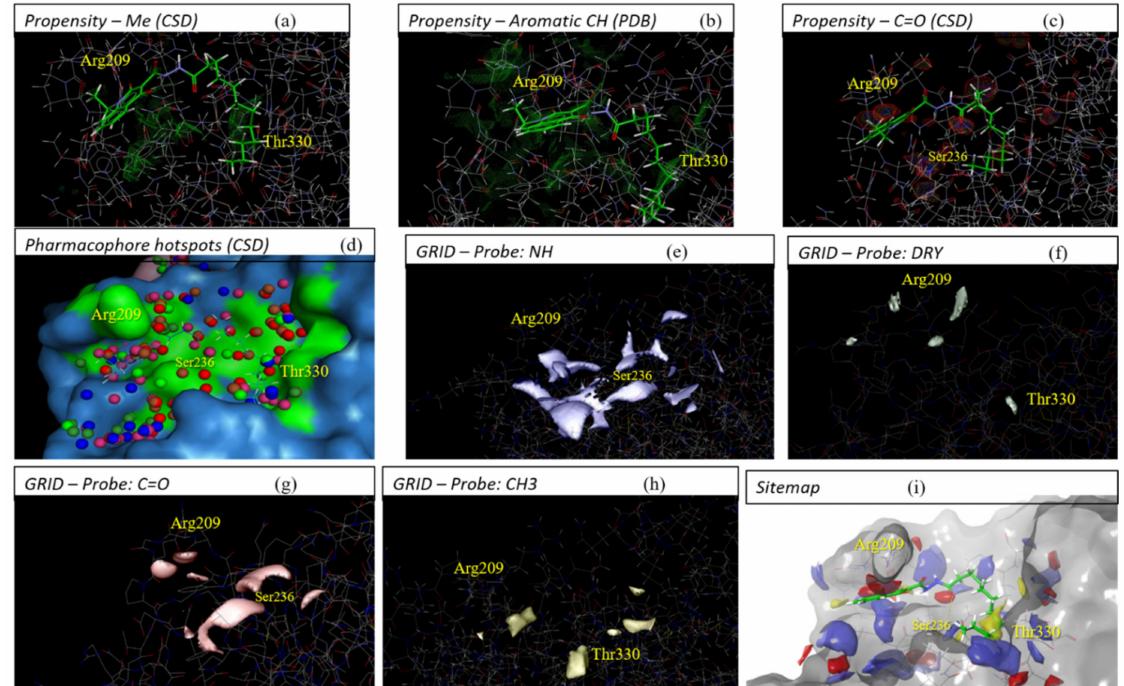
Figure 5. ( a – c ) Contour maps generated with Superstar based on CSD/PDB data, using propensity function and the respective probes; red dots indicate a chance 2 higher of the probe being found in that position than randomness; green 4 × and blue 8 . ( d ) Pharmacophore hotspots generated by Superstar considering the CSD database; spheres in green (aliphatic × or aromatic C-H), blue (nitrogen, N), and red (oxygen, O). ( e – h ) Surface maps generated by GRID using the respective probes in different ranges of energy interactions. ( i ) Surface maps generated by Sitemap; maps in yellow (hydrophobic), red (hydrogen bond acceptor), and blue (hydrogen bond donor). All images show Pocket 7 of GSK-3 β (1PYX.pdb); where possible, compound 1 (Glide pose) was superimposed for